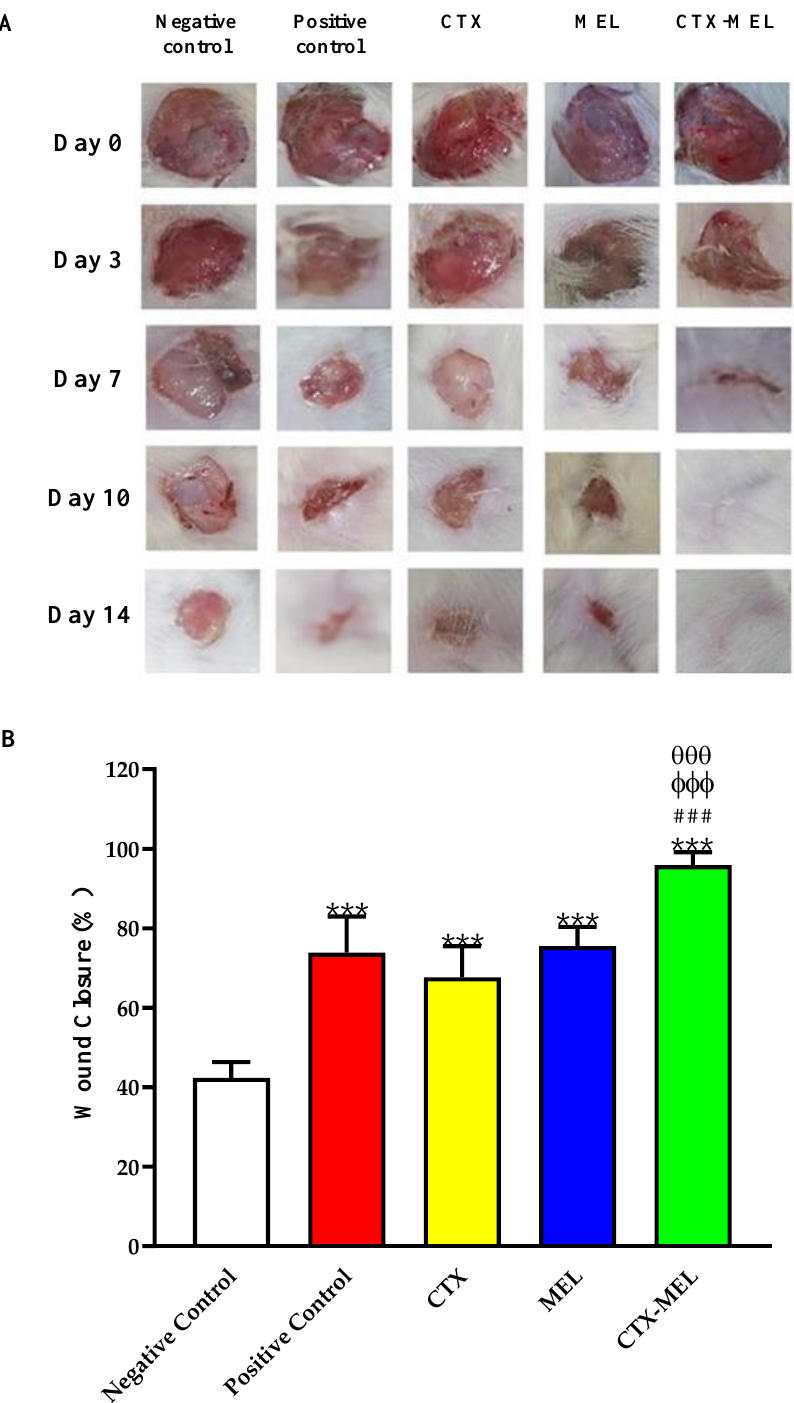
Figure 2. ( A ) Wound closure in diabetic rats belonging to the 5 experimental groups at day 0, 3, 7, 10, and 14. ( B ) Wound closure % at day 14. Negative control refers to rats that received topical plain vehicle consisting of HPMC-based hydrogel (1.5% w / v ) on the wound area, while positive control refers to animals that received 0.5 g of Mebo TM ointment on the wound area. Data are expressed as mean ( n = 6) ± SD. *** Significantly different vs. negative control, p < 0.001; ### significantly different vs. positive control, p < 0.001; φφφ significantly different vs. CTX, p < 0.001; θθθ significantly different vs. CTX, p <